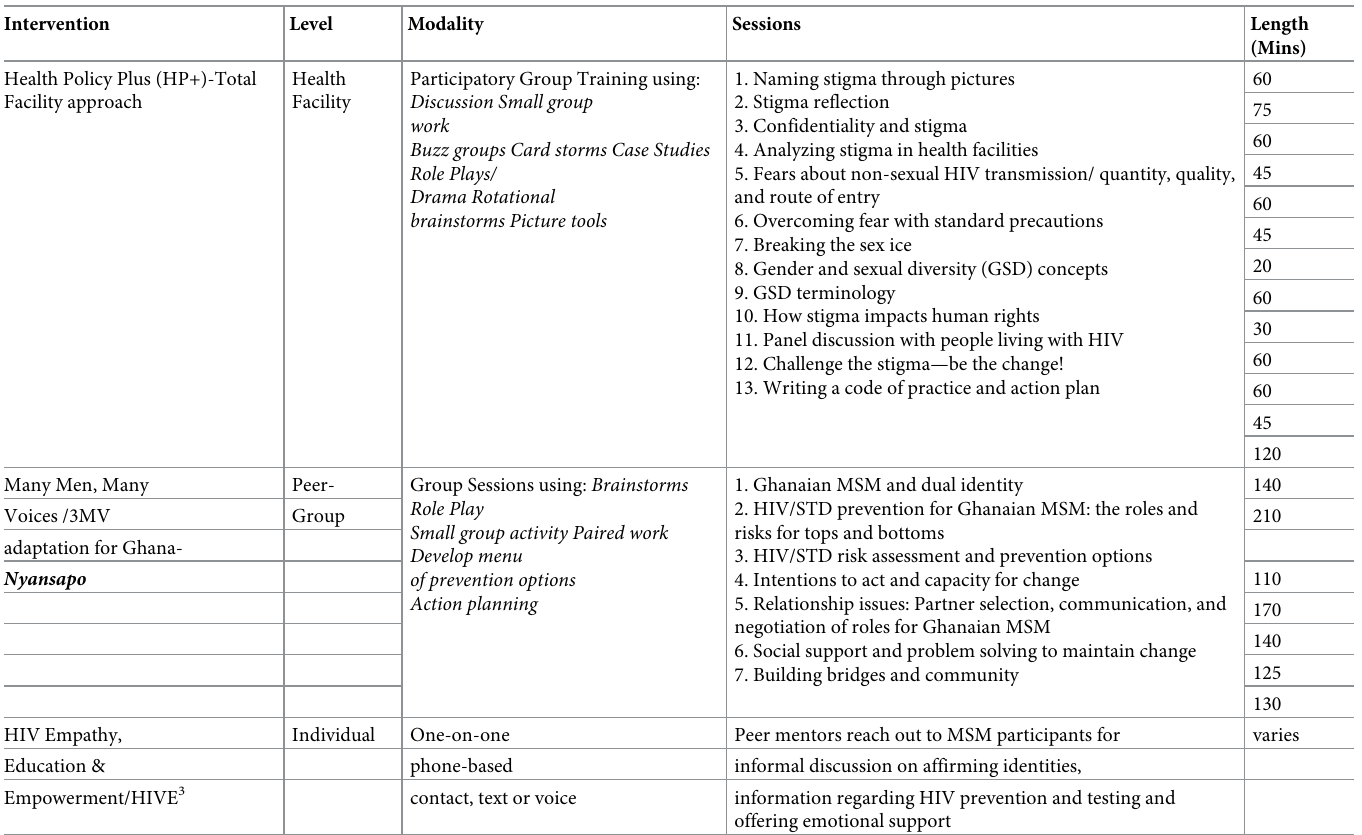
Table 1. Summary of the Three Single-Level Interventions for the proposed